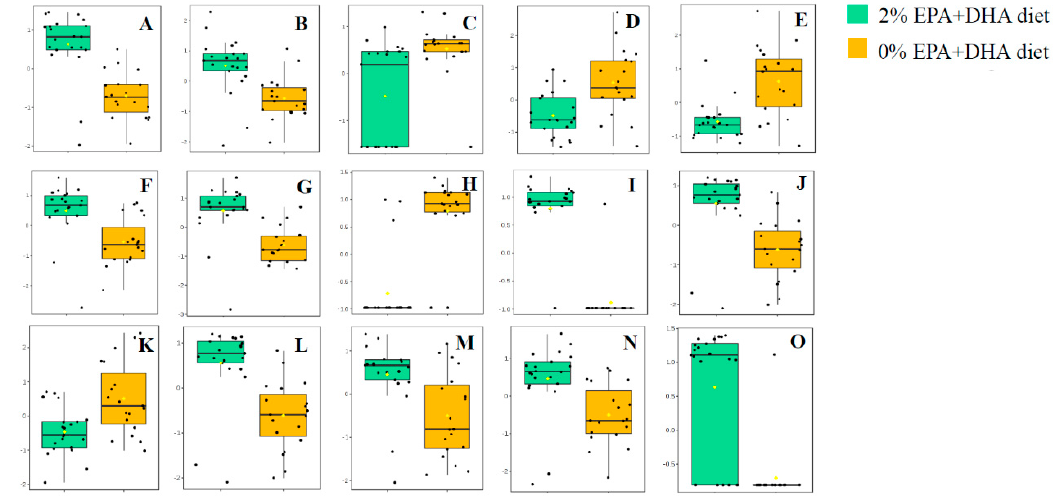
Figure 5. Box-plots demonstrating the median (central bar), 25% and 75% metabolite intensities of the compounds impacted by omega-3 supplementation, with n ≈ 20 per supplementation group. ( A ) eicosapentanoic acid, ( B ) docosapentanoic acid, ( C ) eicosadienoic acid, ( D ) PG 20:4/22:6, ( E )